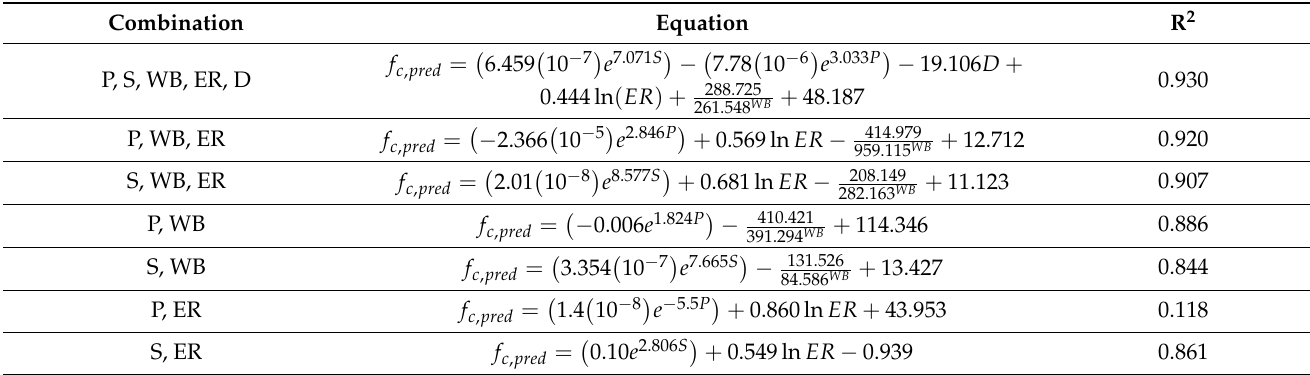
Table 7. Summary of nonlinear equations obtained from different parameter